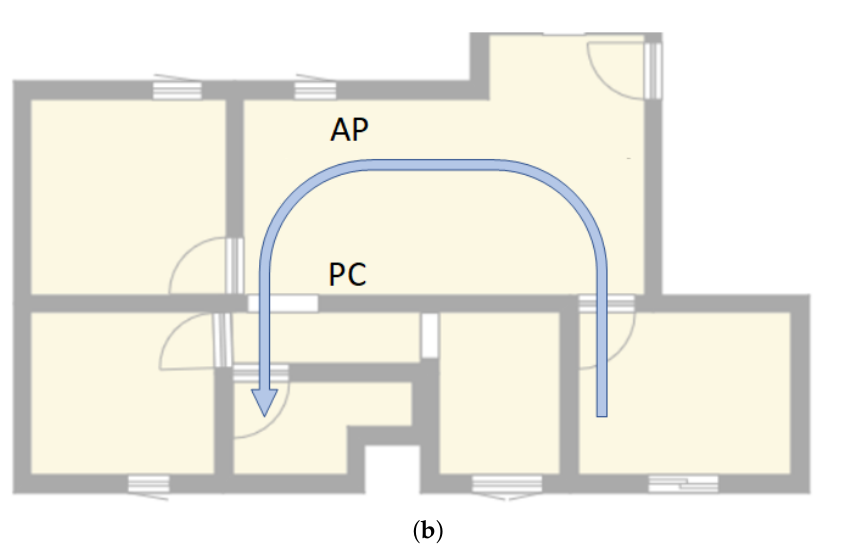
Figure 5. Paths taken in scenario 1: ( a ) returning to the initial position; ( b ) ending the path in a different room.